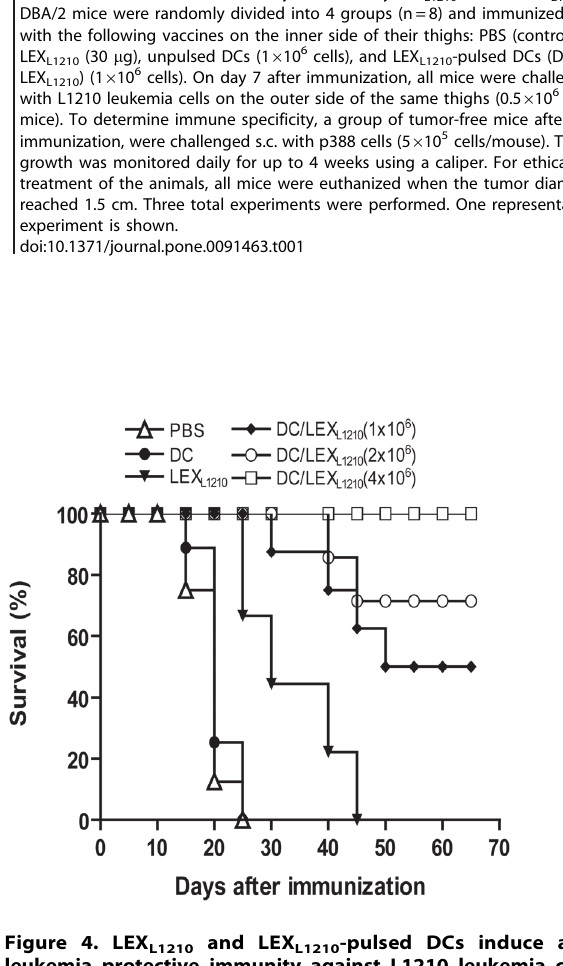
Vaccines Tumor cell challenge Incidence of tumor growth (%)